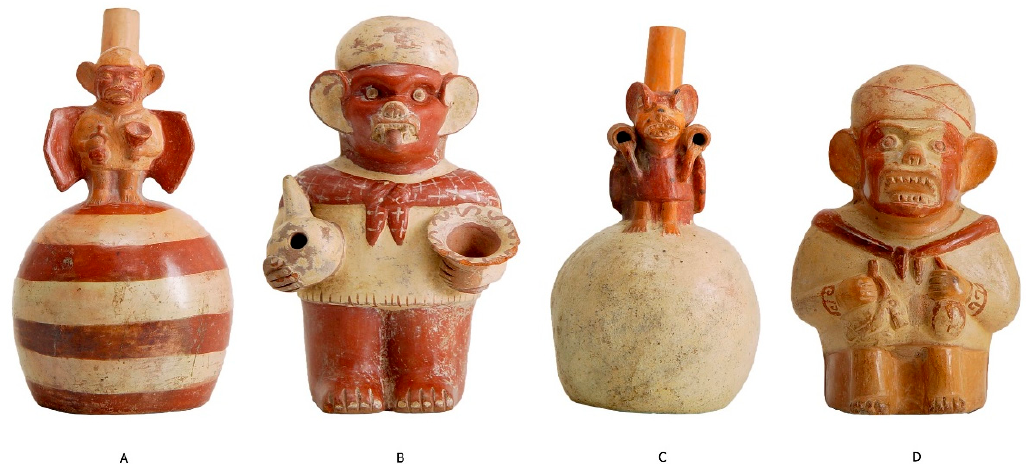
Figure 3. Anthropomorphized bats holding different vessels: ( A ) bat holding a stirrup jar and flaring bowl (ML003458); ( B ) bat holding canchero (or dipper) and florero (ML003474); ( C ) bat carrying two ollas (domestic pots) on shoulders (ML003456); ( D ) bat holding two stirrup jars, one in the form of a duck (ML003484) (Museo Larco, Lima—Perú).